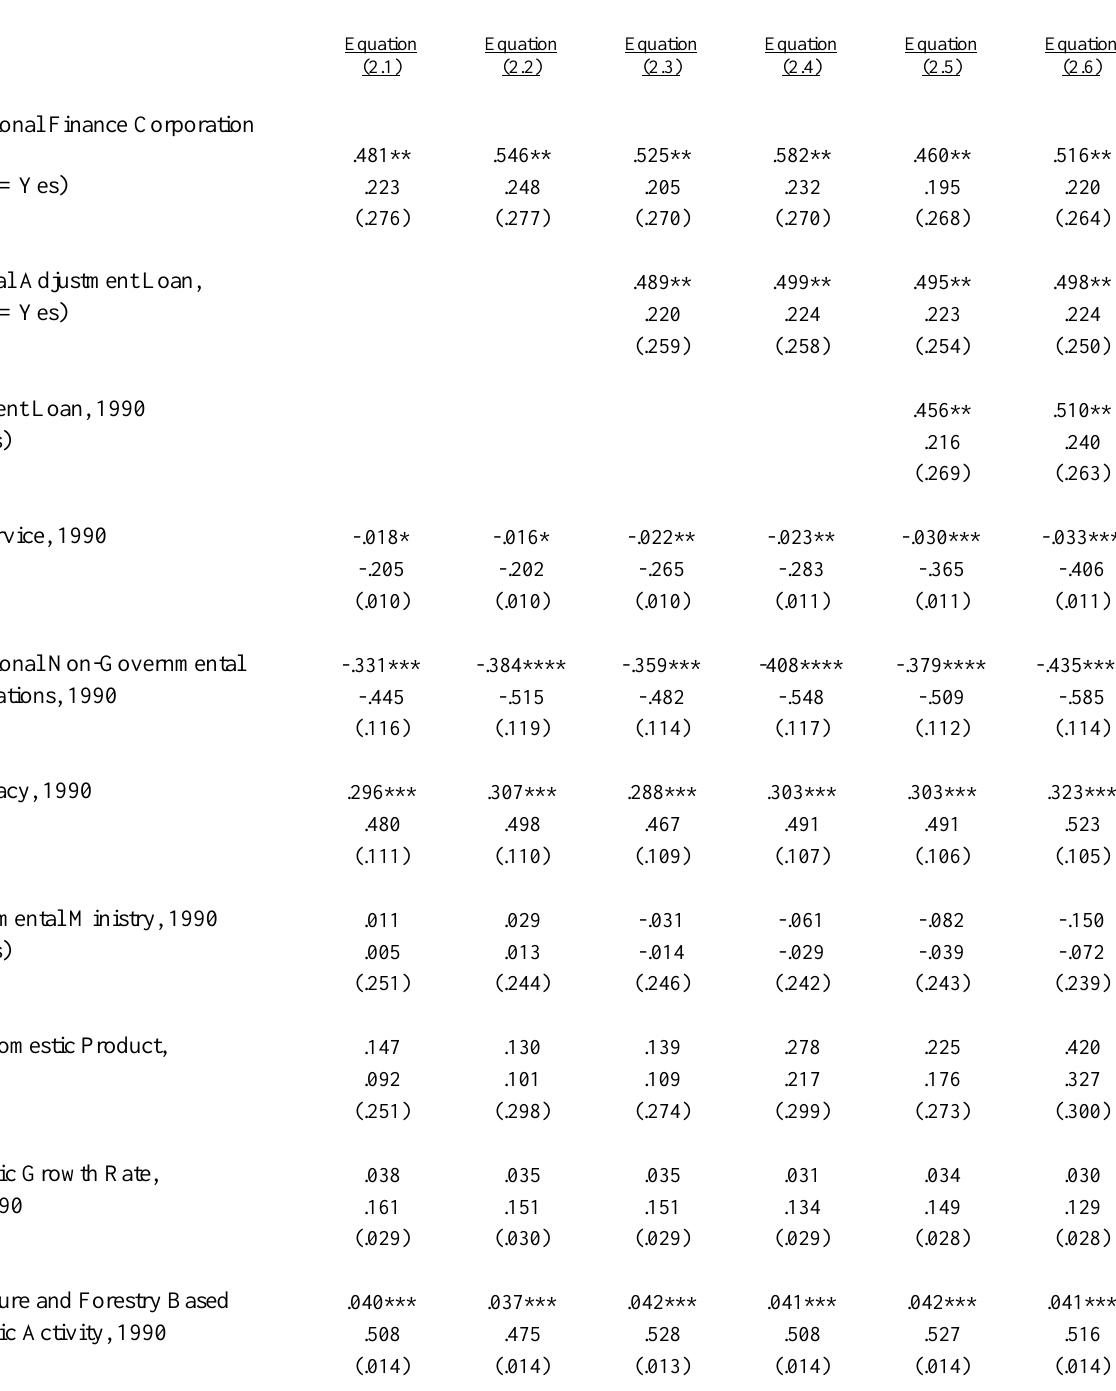
Table 2. Estimates of Deforestation, 1990-2005